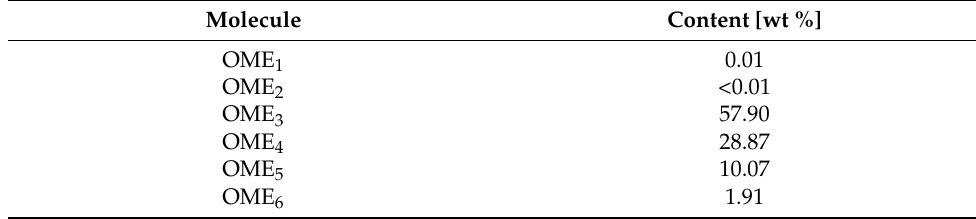
Table 1. OME mix composition.